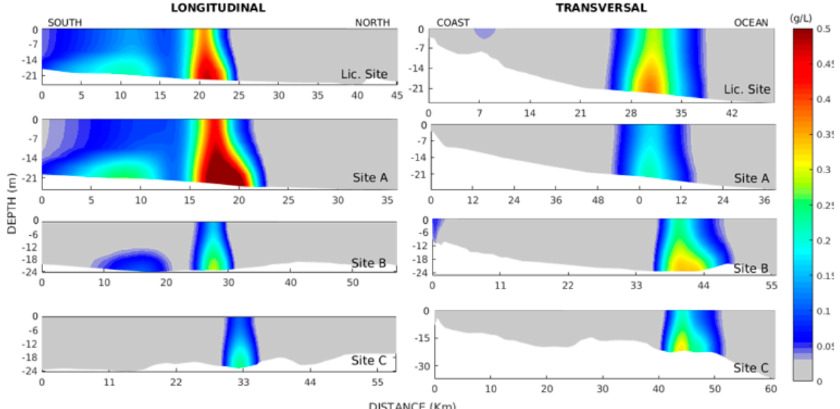
Figure 10. Longitudinal ( left column) and transversal ( right column) profiles representing the dispersion plume throughout the vertical after 292 discharges (starting on 19 December 2013 at 00:00 h) on the Licensed and alternative disposal Sites A, B and C. Color scale indicates suspended sediment concentrations (g/L), where gray indicates concentrations lower than 0.025